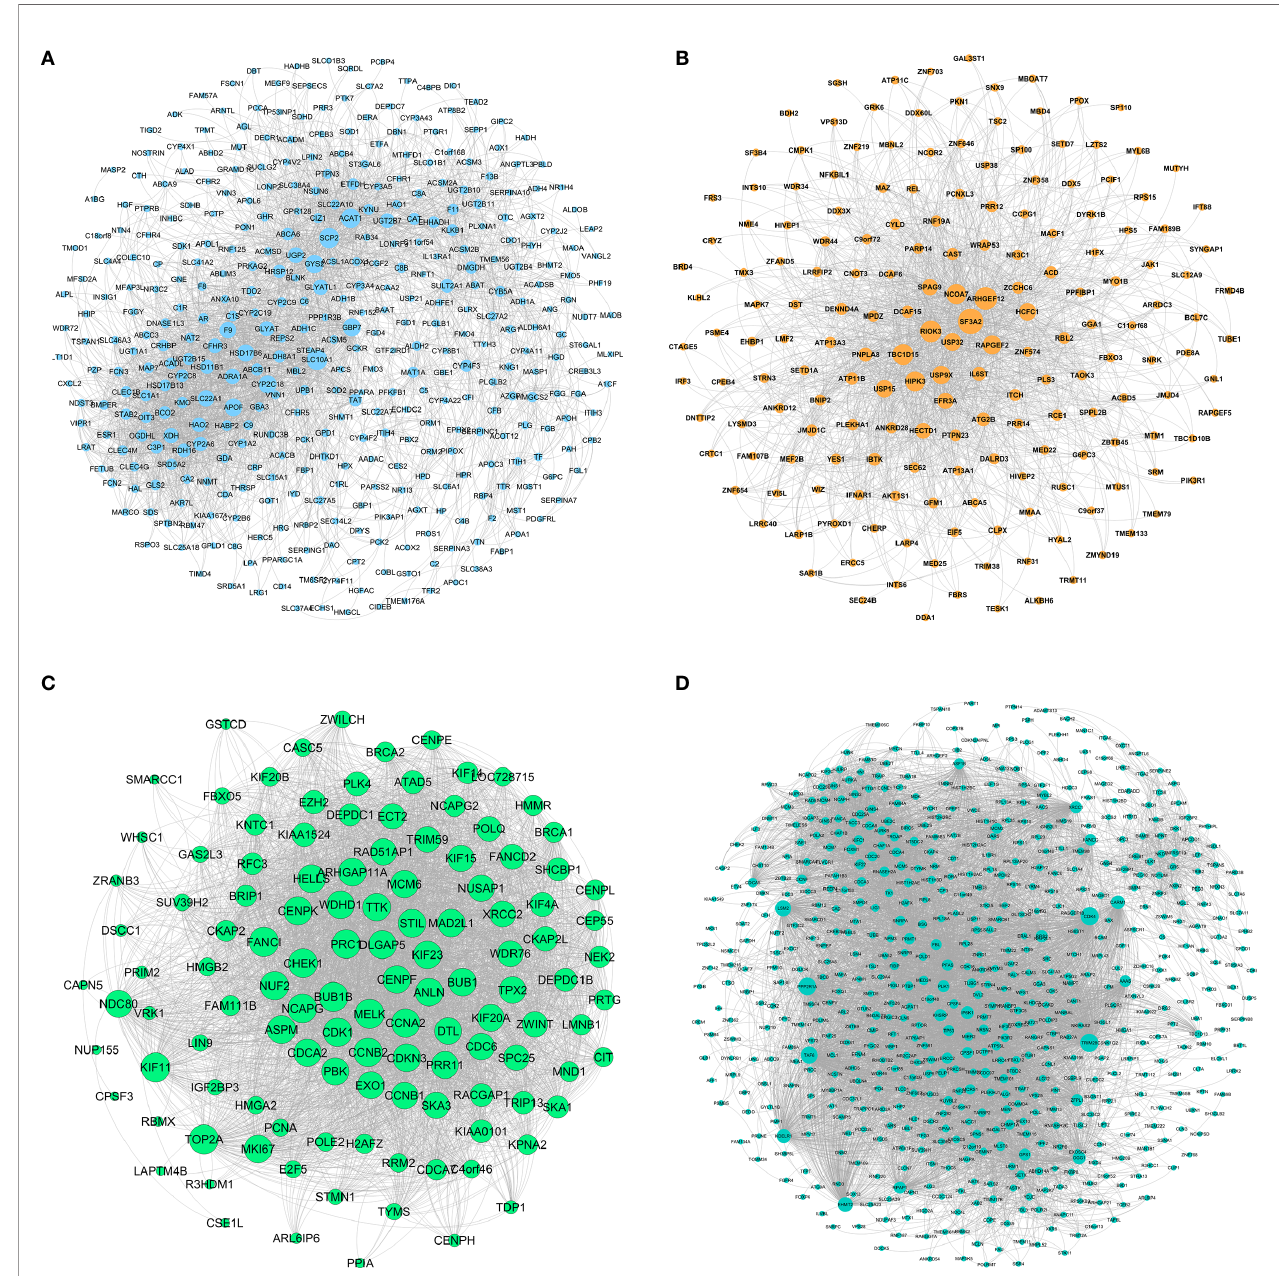
FIGURE 5 | Gene symbols and gene interaction in the four modules, as determined by ClueGO. (A) Blue module; (B) Brown module; (C) Green module; (D) Turquoise